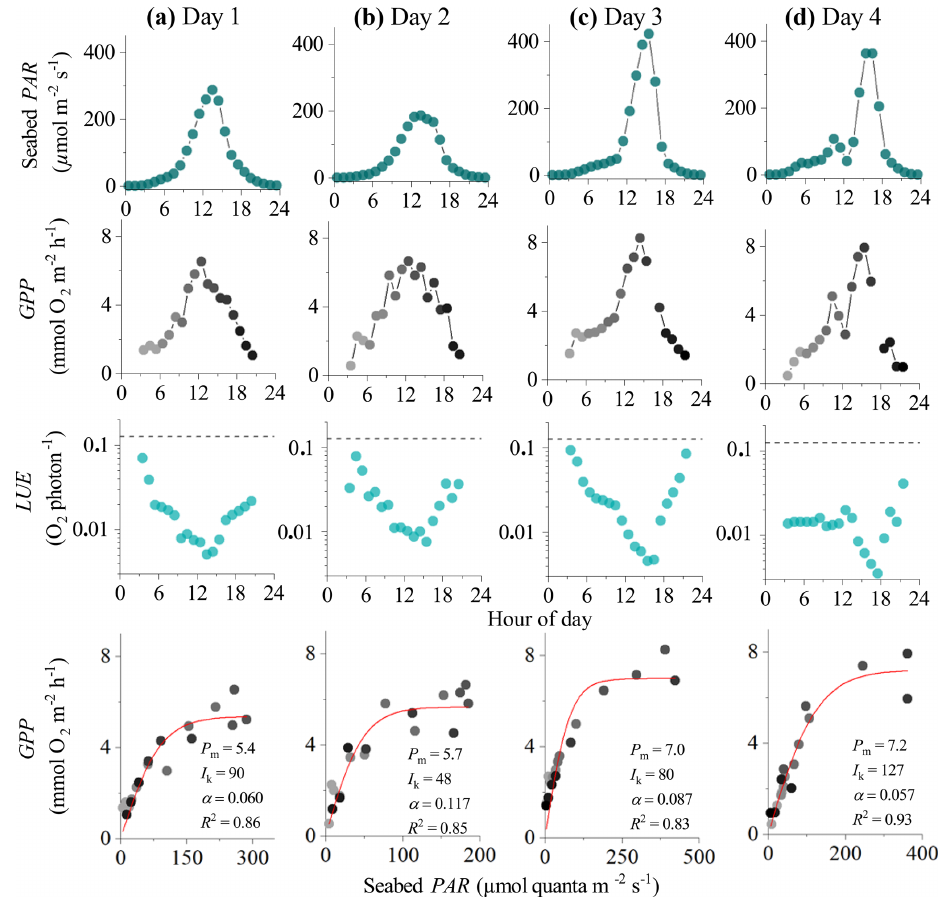
Figure 3. Eddy covariance data measured over 4 consecutive days in the sedimentary embayment in Greenland showing seabed PAR (top panels), hourly GPP (b) , estimated hourly LUE ( c ; dashed lines indicate theoretical limit), and corresponding light saturation curves (bottom panels). Symbols in the second and fourth rows are colour-mapped by hour of day. Light saturation curves are fitted to the data showing the maximum rate of GPP ( P m , mmolO 2 m − 2 h − 1 ), the photoadaptation parameter I k (µmol PARm − 2 s − 1 ), the initial slope of the curve α , and the coefficient of determination ( R 2 ). Data modified from Attard et al.